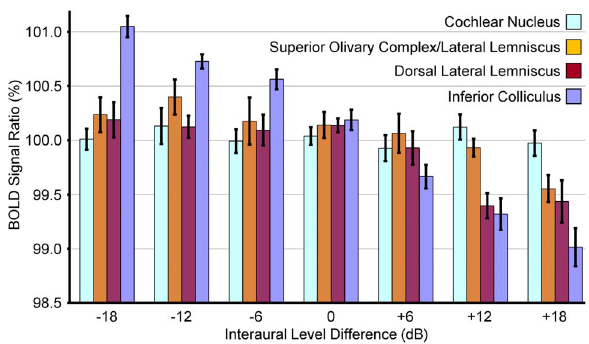
Figure 5. BOLD signal ratios for different structures and ILDs. Mean and standard error (across all animals) of BOLD signal ratios computed for each structure with the ROIs in Fig. 2. The ratios were computed at each ILD by dividing the BOLD signal in the left hemisphere ROI by that in the right hemisphere ROI. The units are percentage of right hemisphere signal. A ratio of 100% indicates equal signal in the two hemispheres. The SOC/LL, DLL, and IC ratios exhibit a trend of decreasing ratio from 2 18dB to + 18dB ILD while the CN ratio does not exhibit significant changes with ILD.